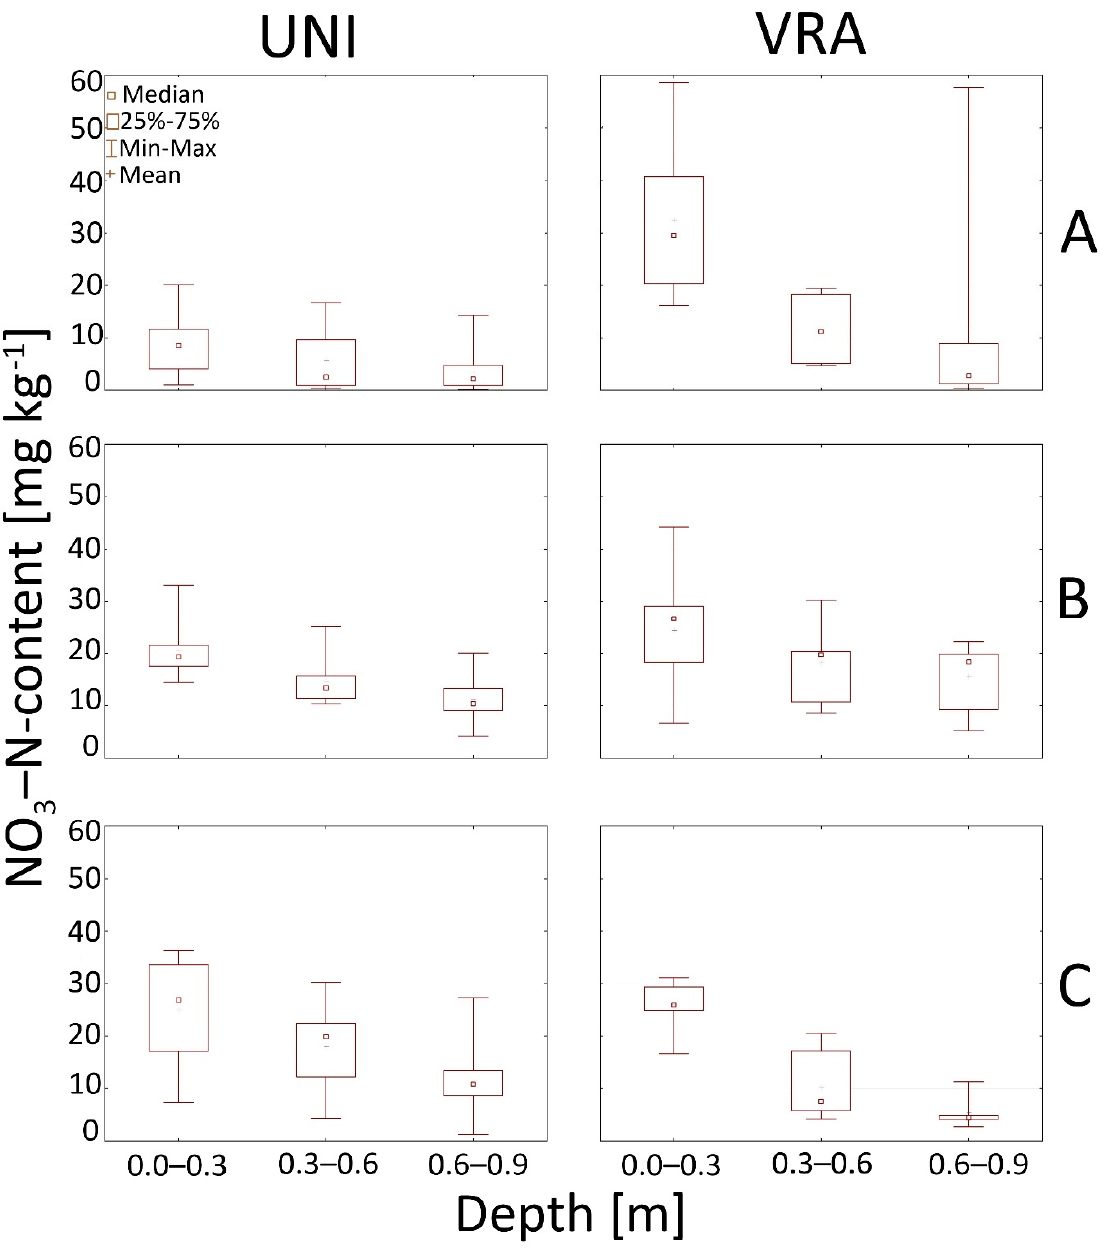
Figure 6. Box and whiskers plots presenting nitrate content in the soil after UNI and VRA fertilization at the analyzed experimental sites A, B, and C. ( A – C ).